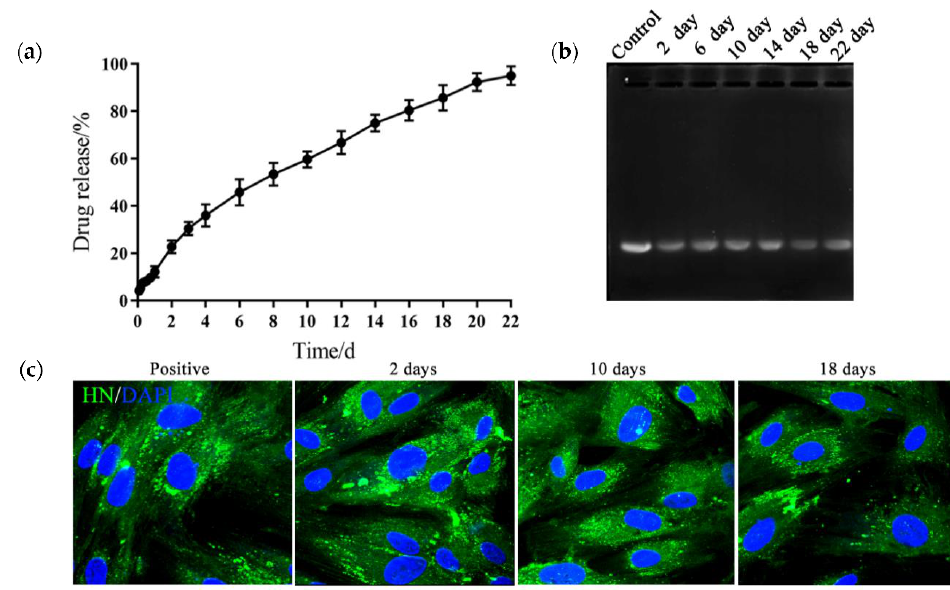
Figure 3. PLGA-PEG-PLGA hydrogel consistently released the DNA vaccine and maintained its biological activity. ( a ) The release curve of the DNA vaccine from the hydrogel. ( b ) The electrophoresis image of the release media. Control: plasmids of the NDV HN gene (pVAX1-HN) plasmids. ( c ) Immune fluorescence images of the HD11 transfected with release media. The release media samples from the hydrogel DNA vaccine were collected at 2, 10, and 18 days, then transfected into HD11 cells with liposomes. After 2 days, the cells were incubated with Newcastle disease virus